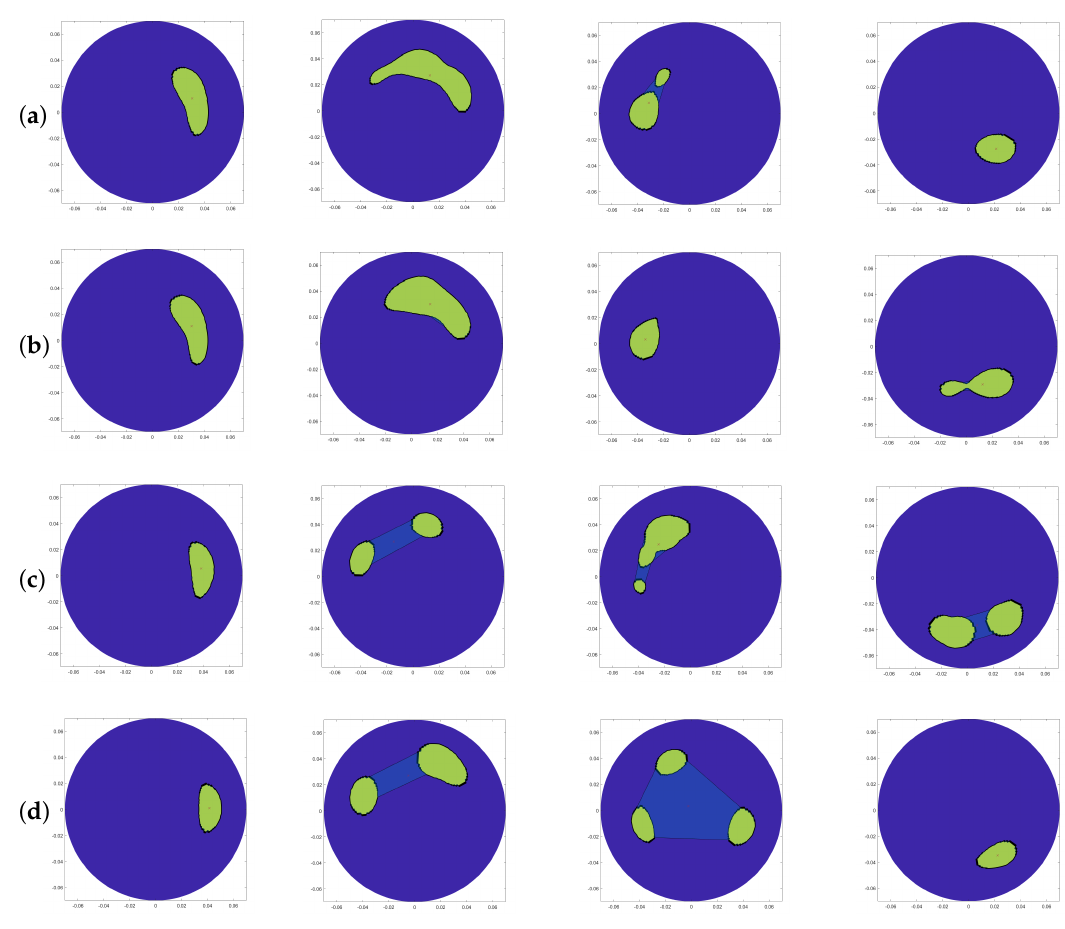
Figure 5. Resulting polyshape images obtained using measured data after performing ( a ) RS, ( b ) LAS, ( c ) DSR, and ( d ) SSD artefact removal methods for inclusion at 0 ◦ , 90 ◦ , 180 ◦ , and 270 ◦ , respectively. Table 1. Signal-to-Clutter ratio (S/C) (linear) for the frequency band between 1 and 1.5 GHz (using